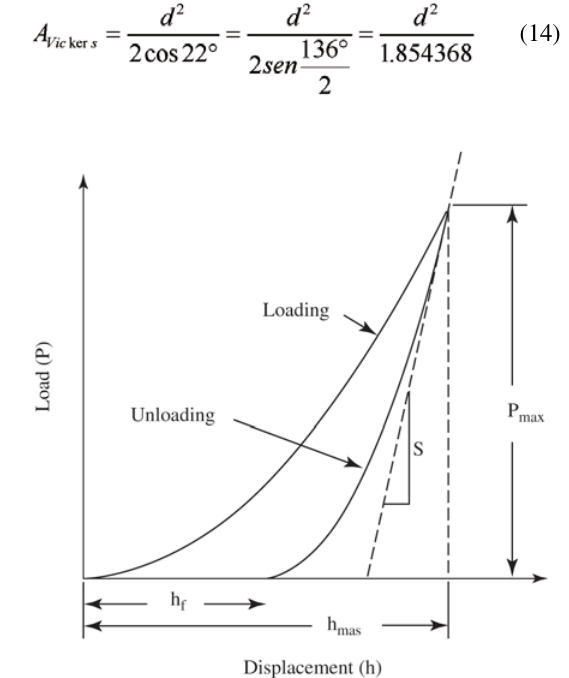
Figure 3. Schematic representation of load-displacement data for a depth sensing indentation